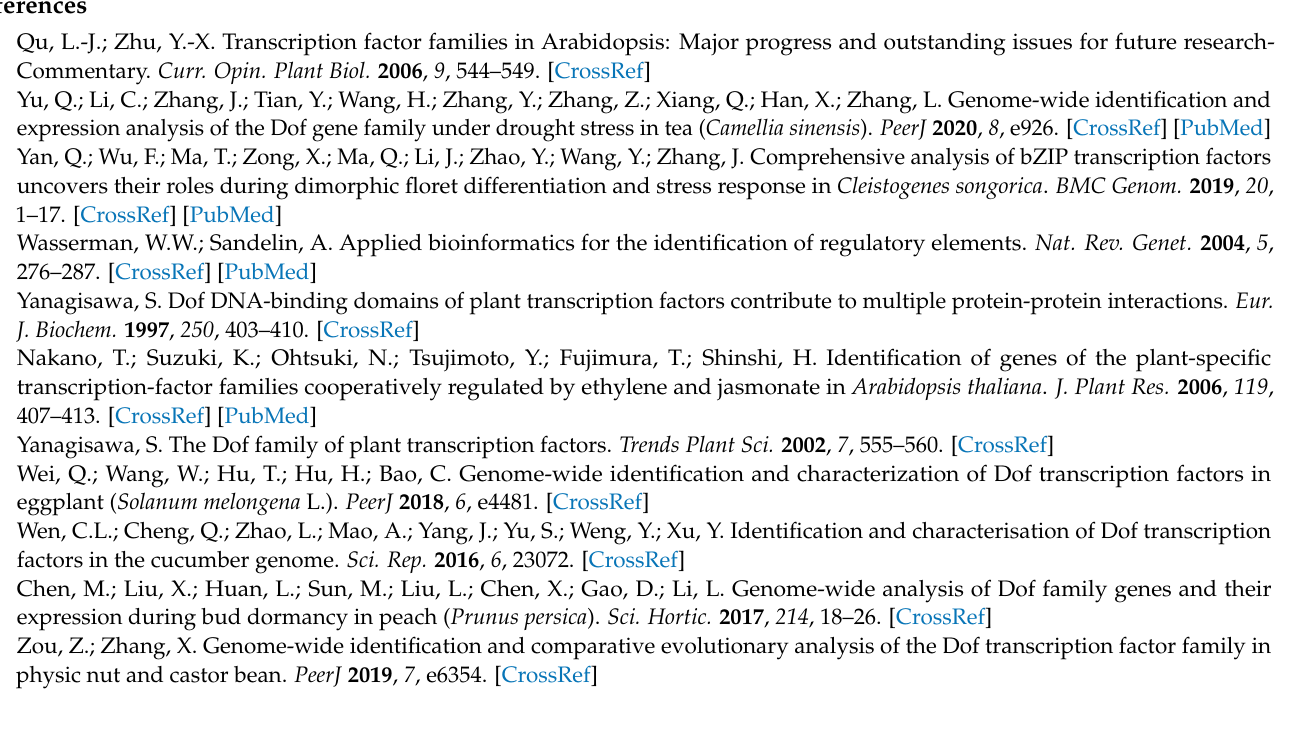
Figure S2: The correlation of real-time PCR analysis and RNA-Seq (FPKM). Table S1: Dof genes identified and characterized in C. songorica . Table S2: Inference of duplication time of Dof paralogous pairs in C. songorica. Table S3: Sequences of primers. Table S4: List of Dof genes of A. thaliana, O. sativa, B. distachyon. Table S5: The expression amount of CsDof genes in C.